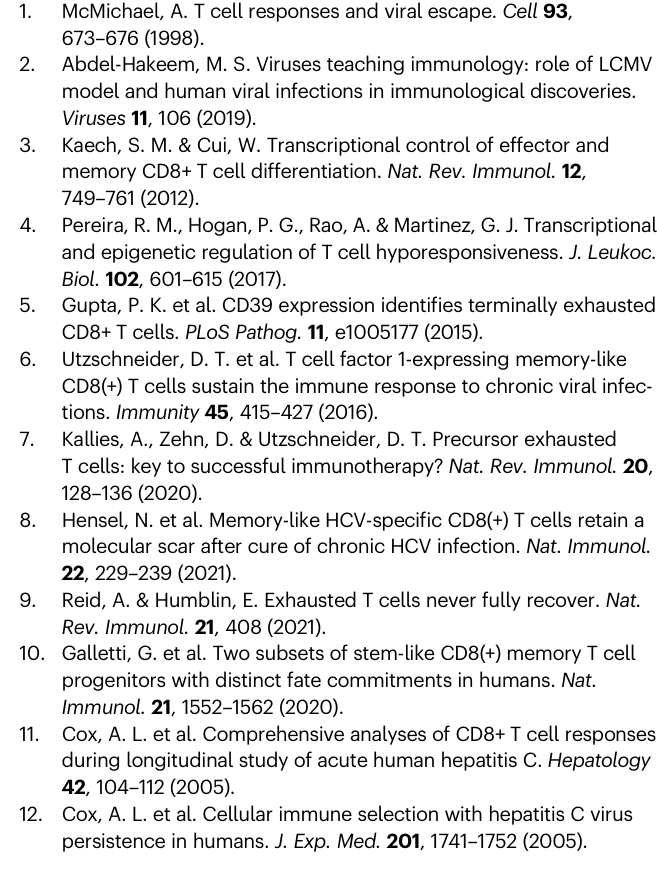
for selected markers with available data (N=369 cells from six biologically inde- pendent sample time points across 4 epitope speci fi cities). Pairwise group com- parisons were performed with two-sided Wilcoxon Rank Sum Tests (* p <0.05, ** p <0.01, *** p <0.001, **** p <0.0001). Shown are the median and 75% range quantiles. e Heatmaps of chromatin accessibility (in purple) and gene expression (in blue) for selected genes. Gene expression is calculated as the average log 10 (TPM+1) of all cells in the early phase ( ≤ 120 DPI) of each immune response. Accessibility and expression values are rescaled between [0, 1] per gene, with higher values represented by darker